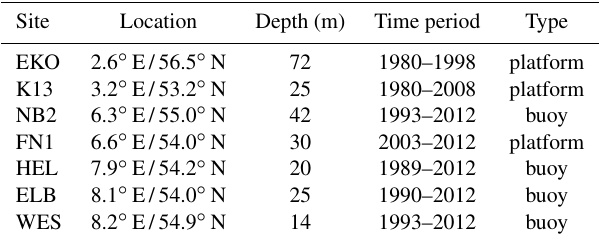
Table 1. Location and description of in situ measurements used for